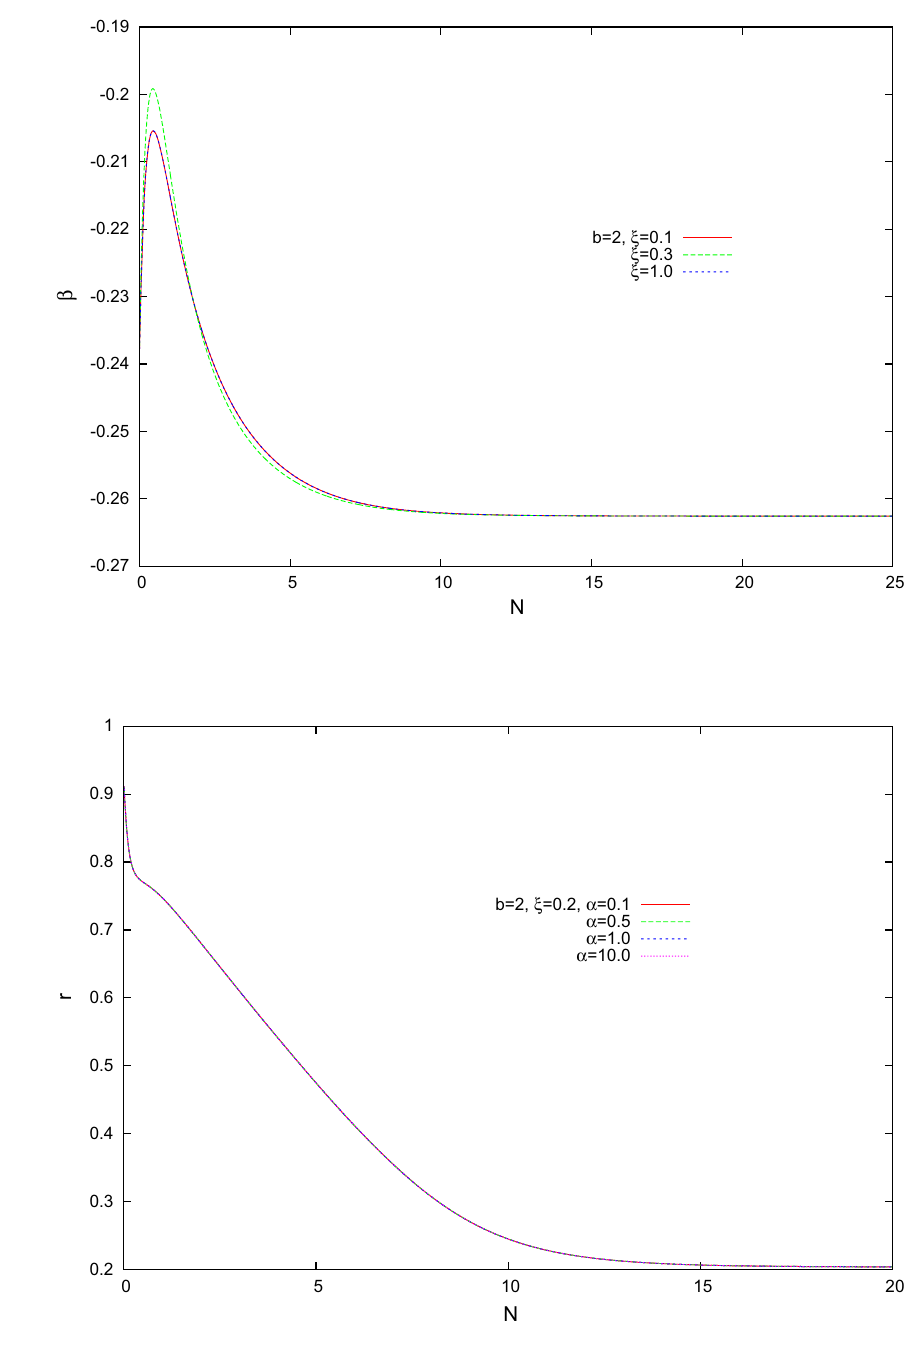
Fig. 5 A graph showing r ( N ) vs. N for ξ = 0 . 2, with varying α values for two